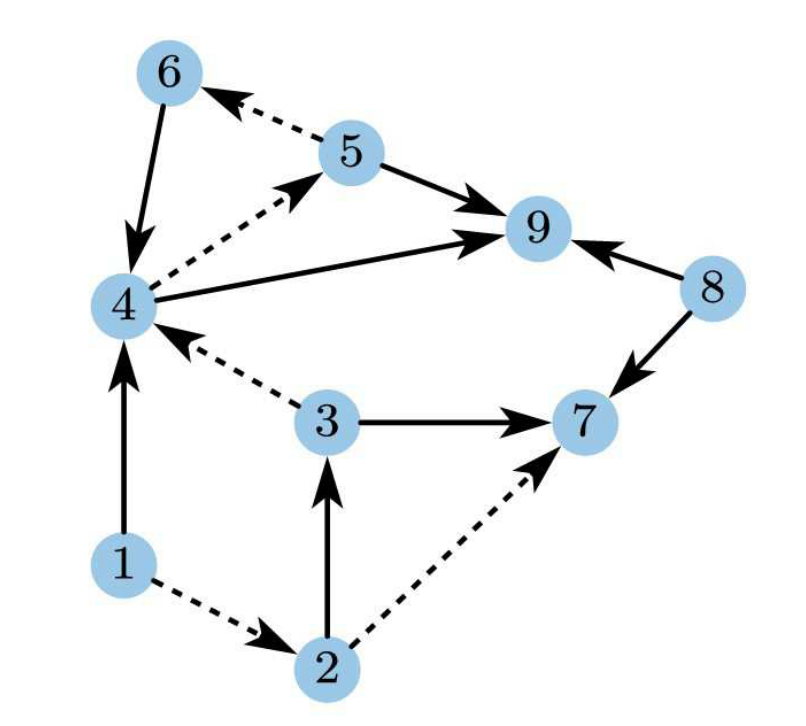
Figure 1. The topological structure of the nine agents in Example